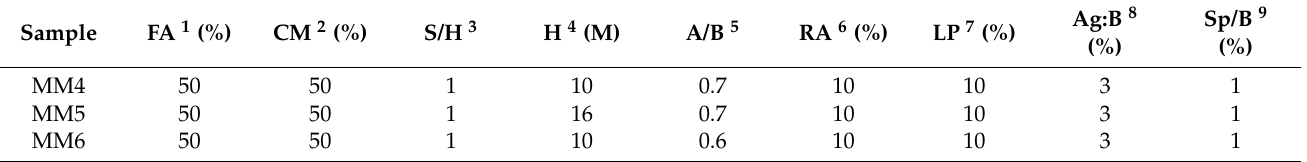
Table 4. Key material ratios of the second group of mortar mixtures.